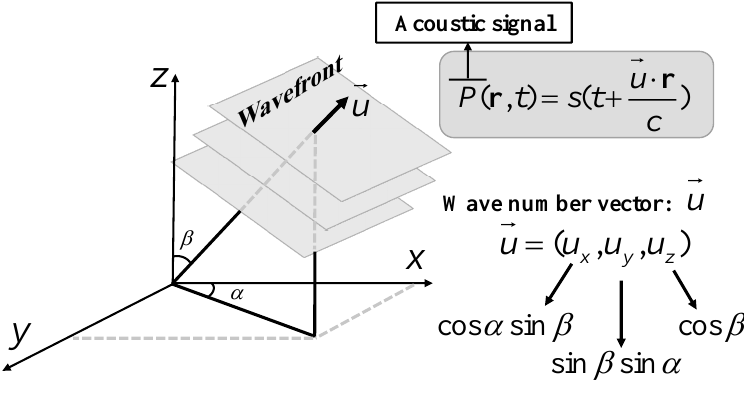
Figure 2. Schematic diagram of infrasound three-dimensional propagation under the assumption of plane waves. (The z -axis is the infrasound propagation height, which corresponds to the z -axis in Figure 1. (cid:126) u is the wave number vector; c is the sound velocity; r is the position vector; P is the acoustic signal when the initial time is t ; and α , β are the angle